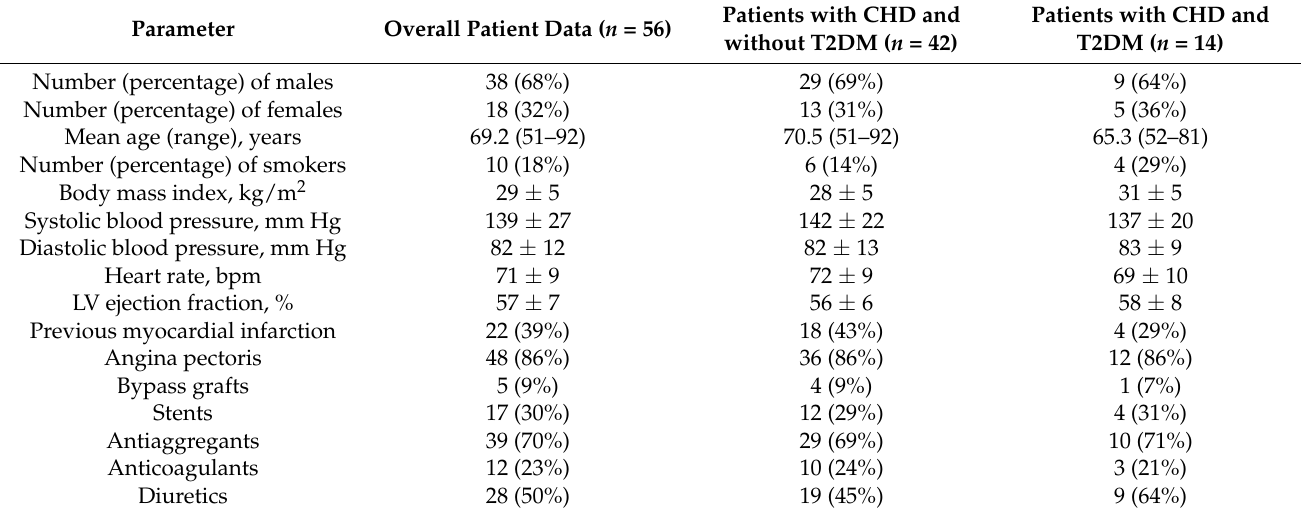
Table 1. The clinical backgrounds for each group of patients, mean ± standard deviation or number (%). Patients with CHD and Patients with CHD and Parameter Overall Patient Data ( n = 56) without T2DM ( n = 42) T2DM ( n = 14) 38 (68%) 29 (69%) 9